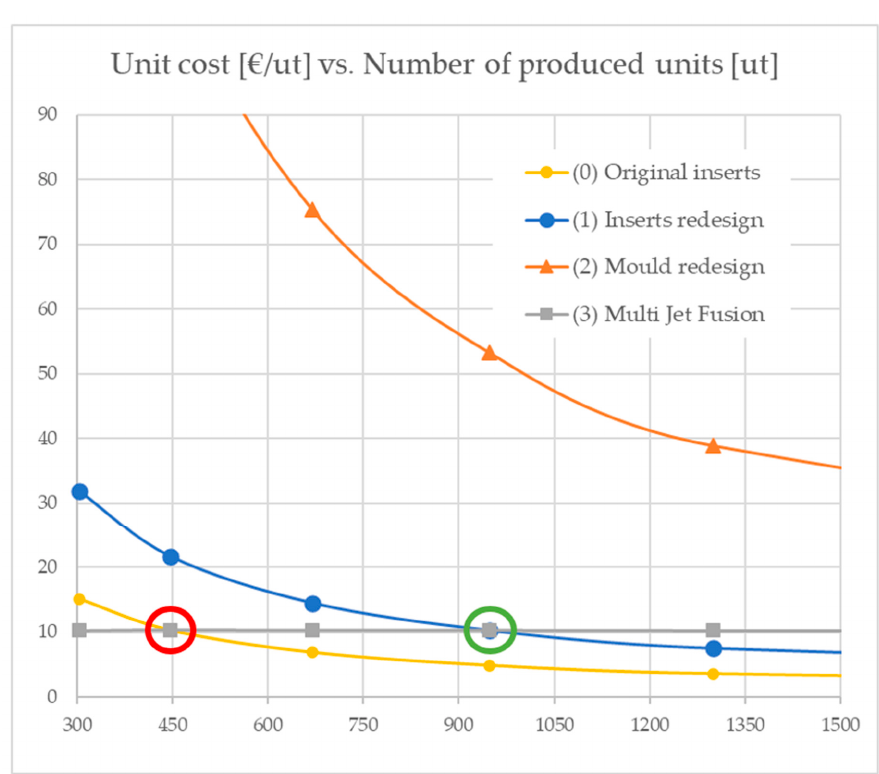
Figure 11. Analysis of the costs per unit produced as a function of the number of produced units for the four scenarios: (0) original inserts, (1) insert redesigns, (2) mould redesigns and (3) multi jet fusion. Equilibrium between (0) and (3) occurs at 446.9 produced parts (red circle) and equilibrium between (1) and (3) at 947.4 (green